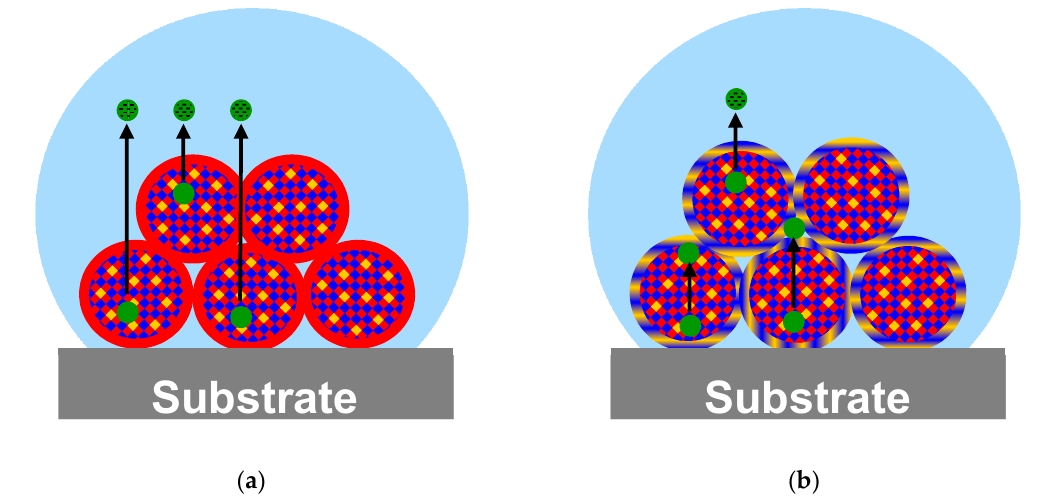
Figure 16. Illustrative presentation of PEC NP immobilized onto the BSM surface during BZM release from ( a ) positively charged PEC 0.7 and ( b ) negatively charged PEC 1.4. Schematically displayed is the less hindered diffusion of the drug through the PEC 0.7 coating in comparison to rebinding of BZM in the PDOPAC containing shell of PEC 1.4. Colors were chosen as follows: PLL: Red; PLG: Blue; PDOPAC: Yellow; covalently bound drug: Green; free drug: Green/black dashed; and release medium: Bright blue.